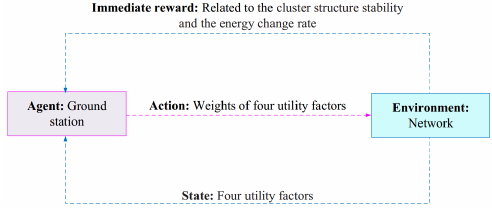
Figure 39. Learning process in ICRA. Table 21. The most important advantages and disadvantages of